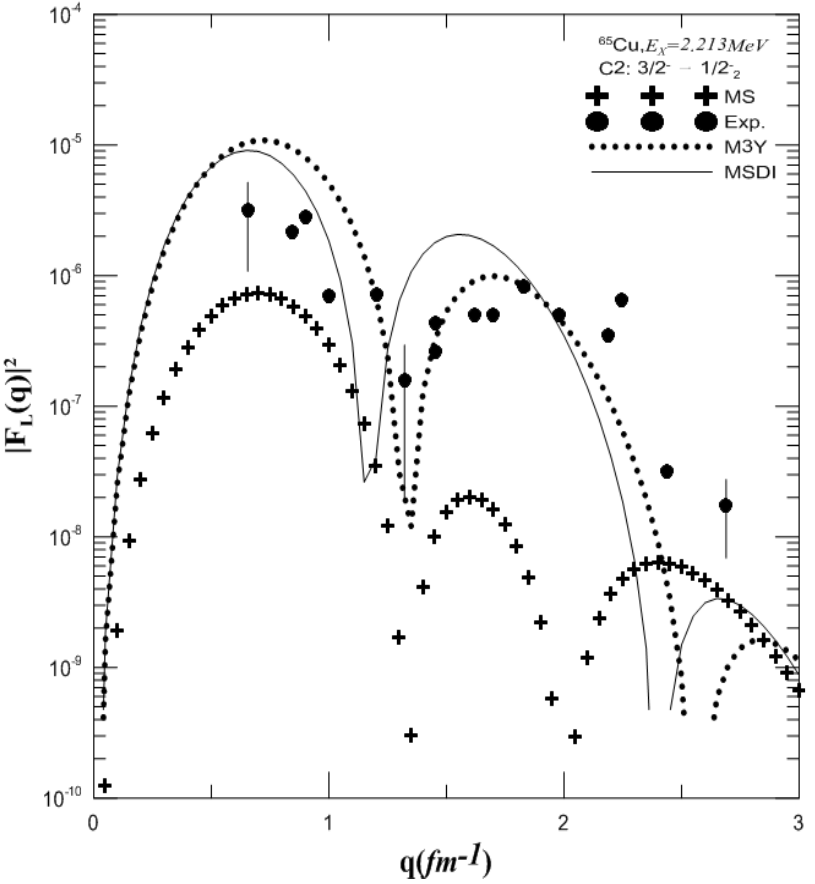
Fig.2: Inelastic longitudinal form factors for C2 transition 3/2 -  using MSDI and M3Y interactions with core-polarization effects, through particle-hole excitations up to 6ћω. The experimental data are taken from Ref.